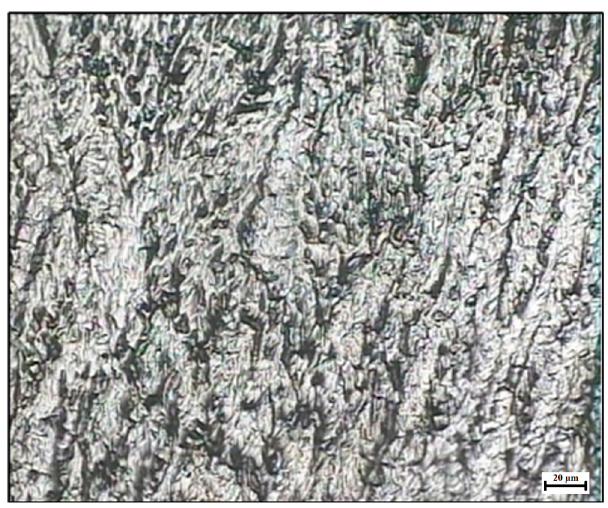
Figure 9. Fusion zone of the weld joint with the E308 electrode type.